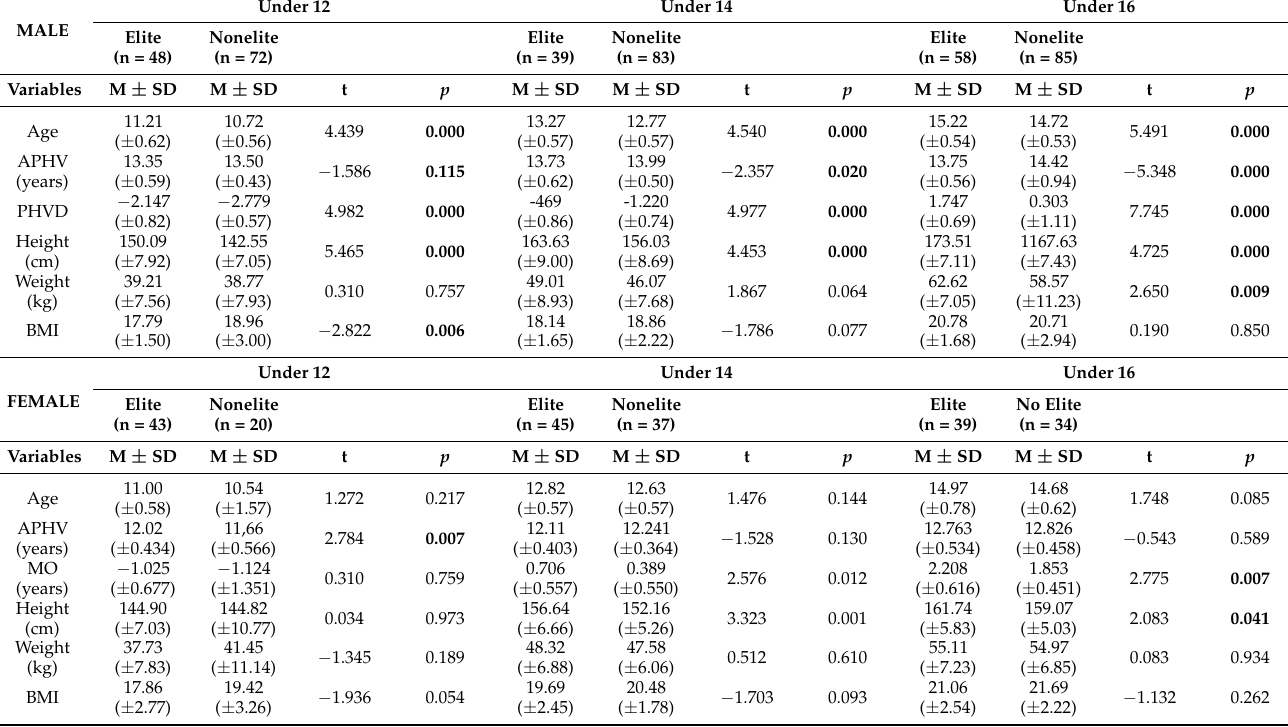
Table 5. Differences between elite and nonelite academies, taking into account category and